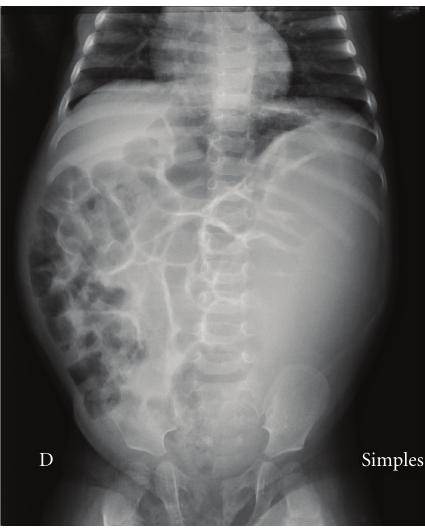
Figure 1: Abdominal plain radiography showing elevation of both hemidiaphragms, prominent gaseous distension of bowel loops, which are completely deviated to the right side of the abdomen, and homogeneous opacity of the left